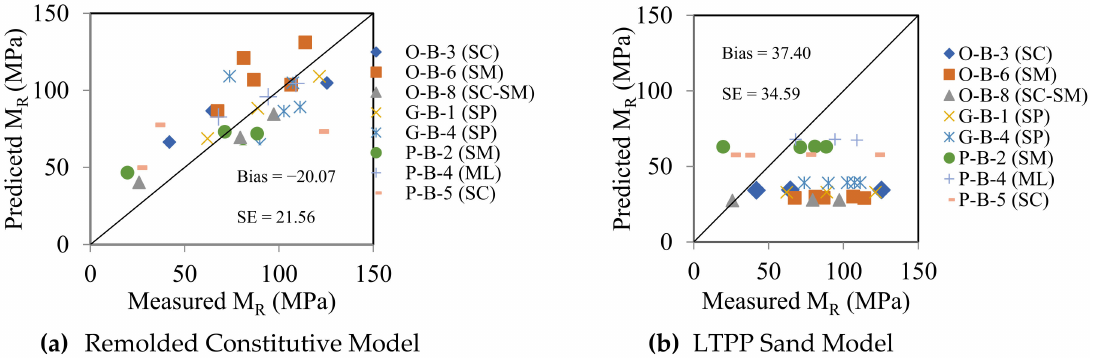
Figure 8. Comparison of Different